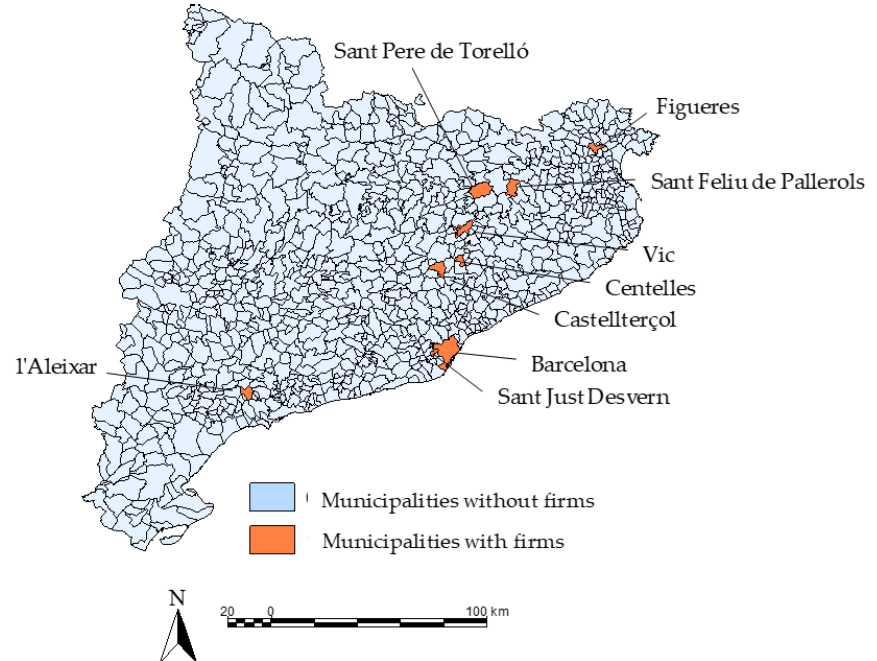
Figure 2. Location of meat-processing companies in Catalonia, 1896. Notes and sources: See Figure 1 and text.